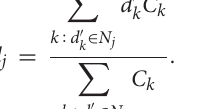
TABLE 2 | CMEMS Quality Flags: their value with meaning and